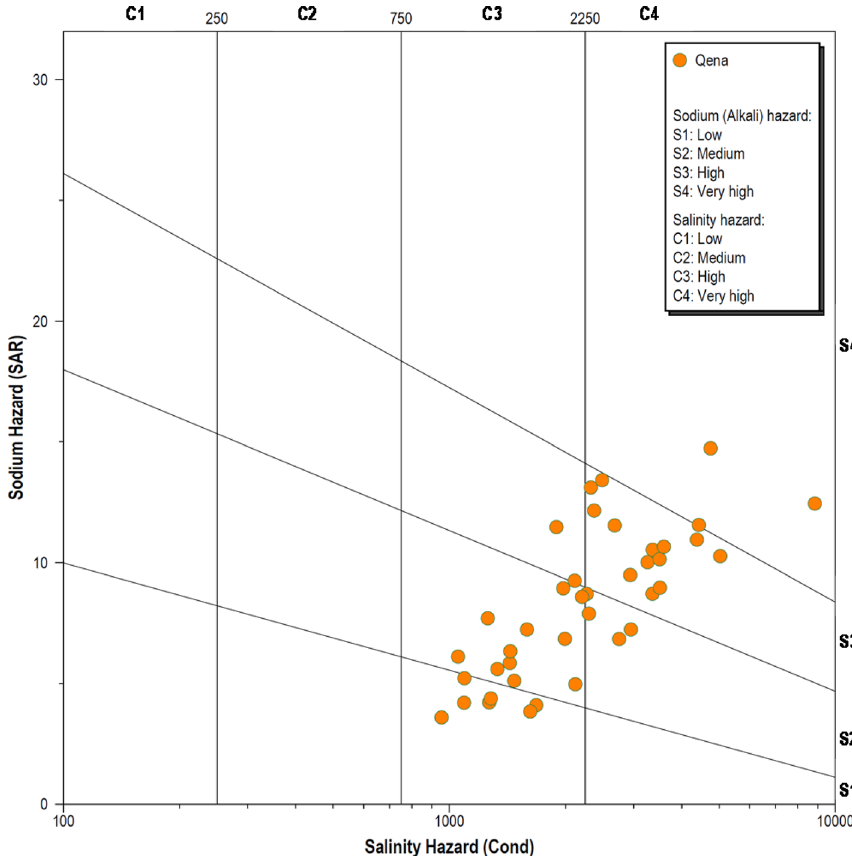
ing the suitability of groundwa- ter for irrigation based on EC and SAR in the study